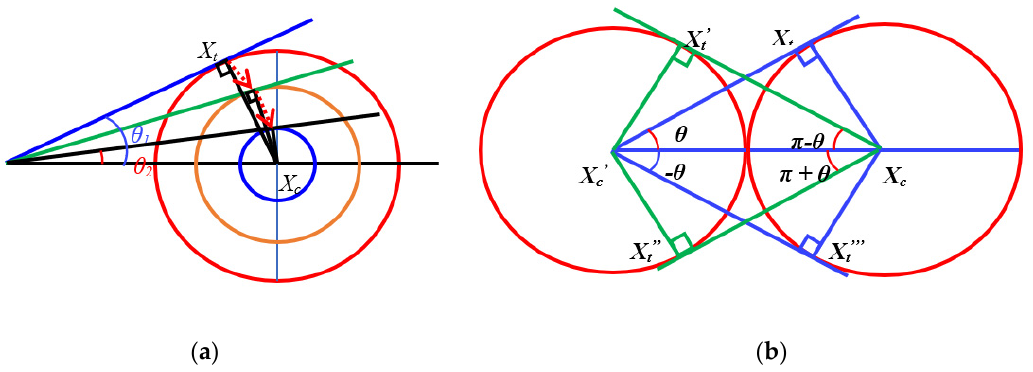
Figure 3. The procedures of the CSA: ( a ) exploitation and ( b ) exploration.